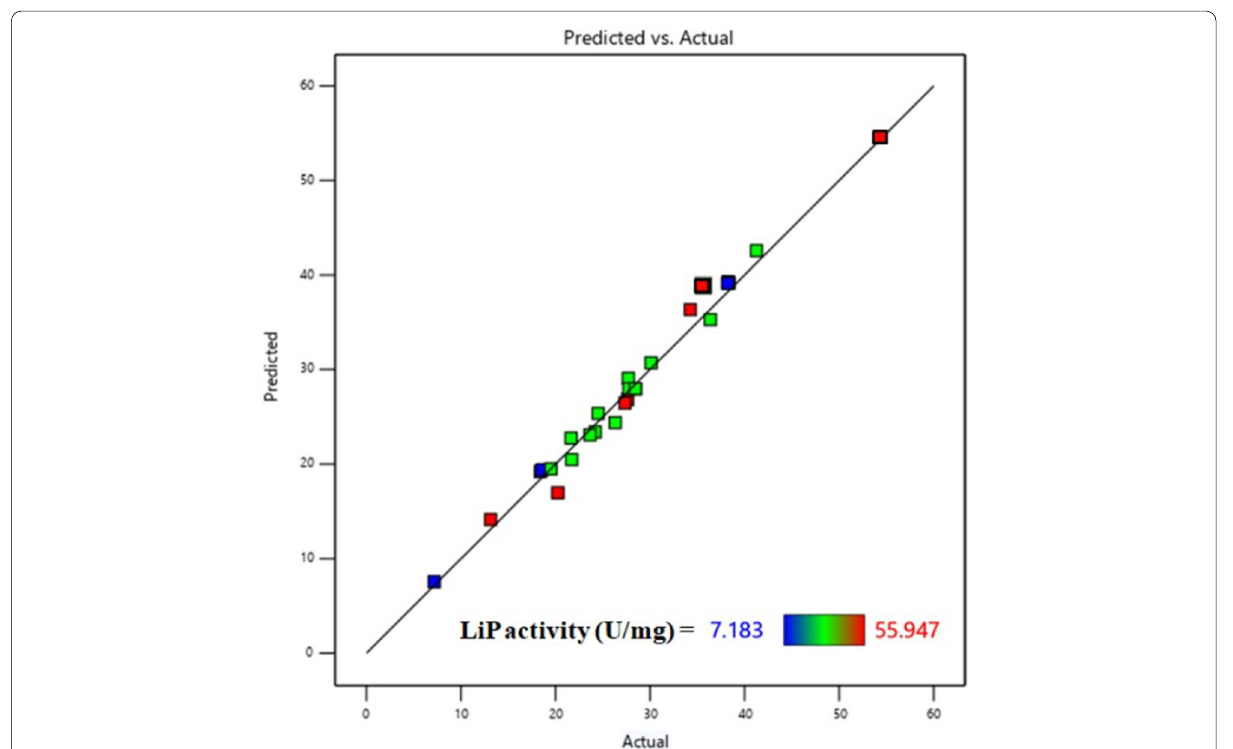
Fig. 9 Residual plots for the LiP activity of the ligninolytic bacterial strain Bacillus mycoides calculated from